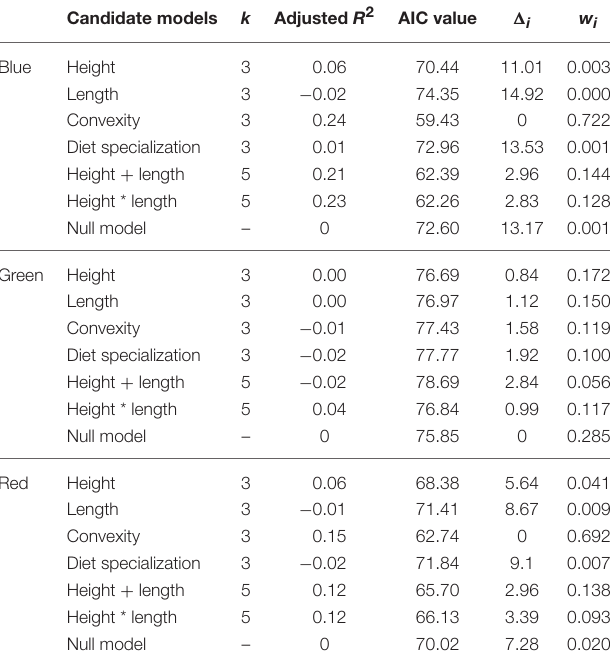
TABLE 4 | Effect of beetle morphology on brightness